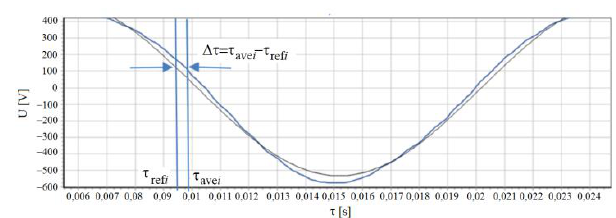
Fig. 9. A fragment of generator's phase-to-phase voltage with the method of calculating the time increment value